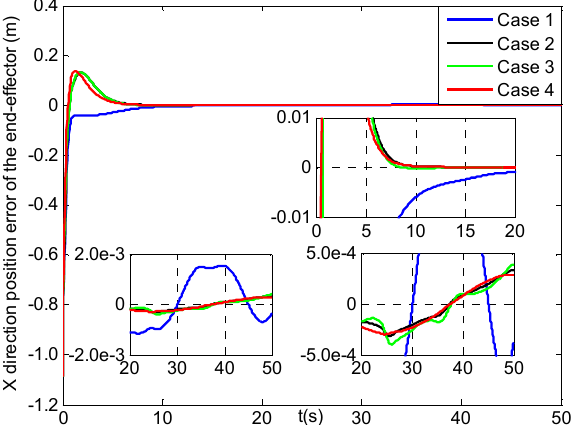
Figure 12. X direction position errors of the end − effector (four cases).